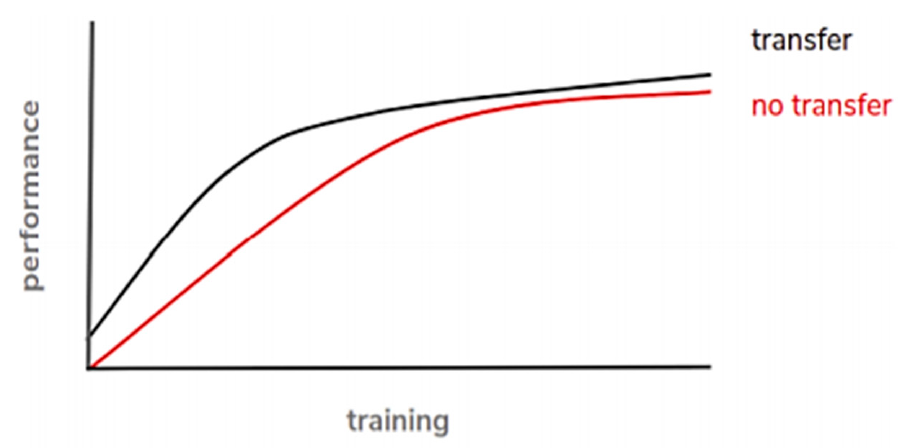
Figure 5. Transfer learning vs. no transfer learning [26].